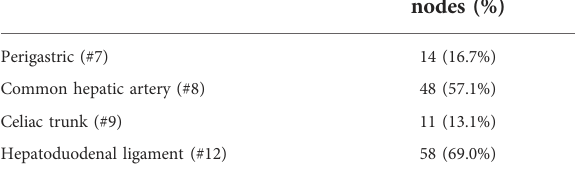
TABLE 2 Distribution of positive lymph nodes in ampullary adenocarcinoma. Group according to JSBS